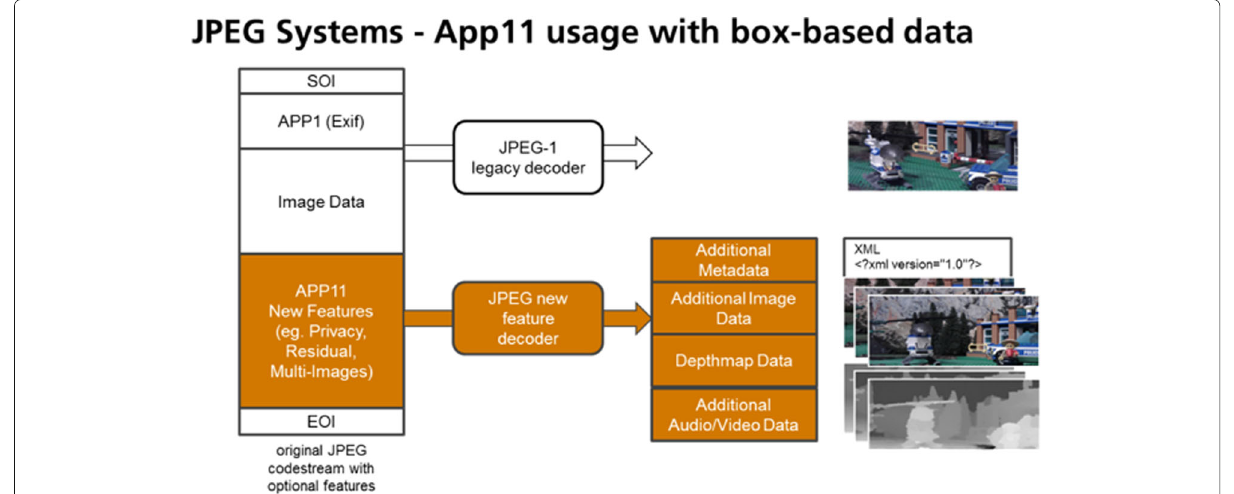
Fig. 3 JPEG Systems - APP11 usage with box-based data